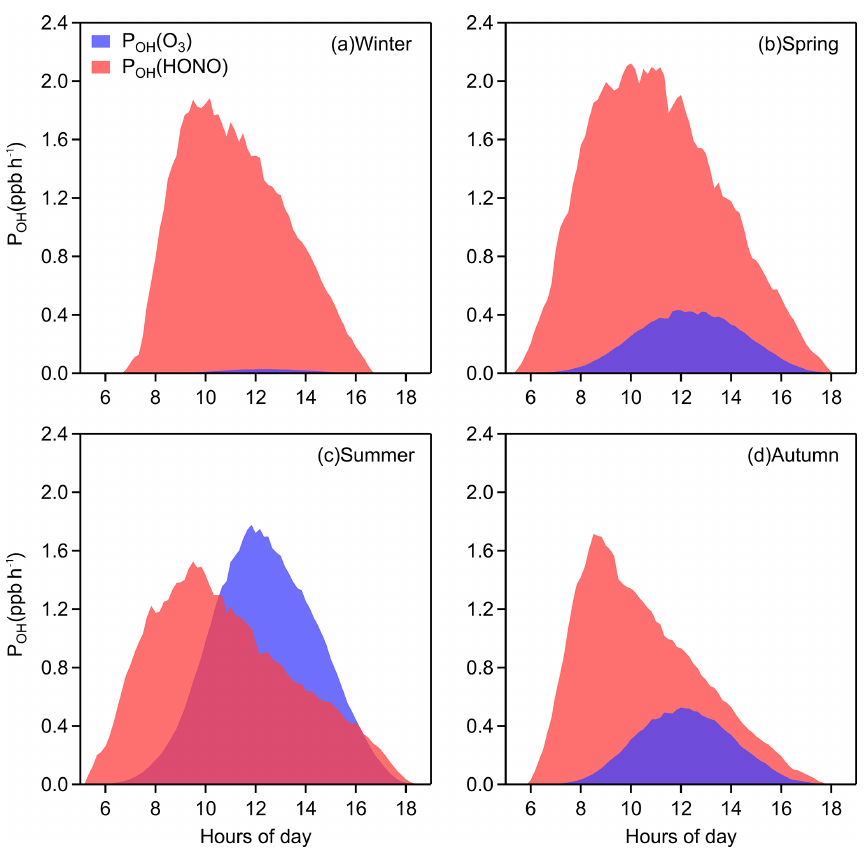
Figure 3. Averaged OH production rates from photolysis of HONO and ozone in (a) winter, (b) spring, (c) summer, and (d) autumn.